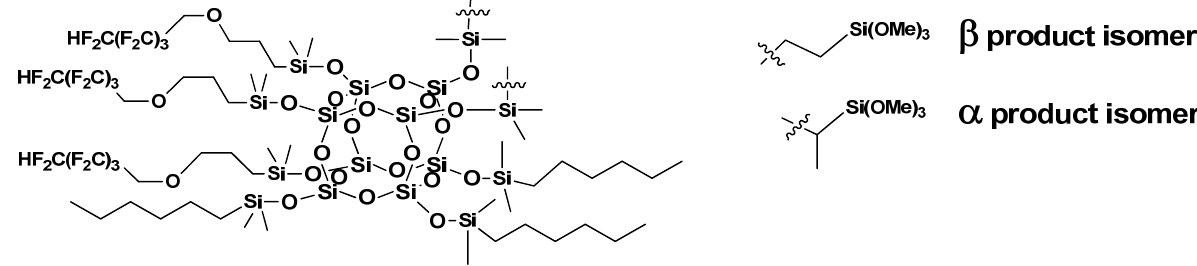
Figure 2. Synthesis of trifunctional POSS ‐ based compound.